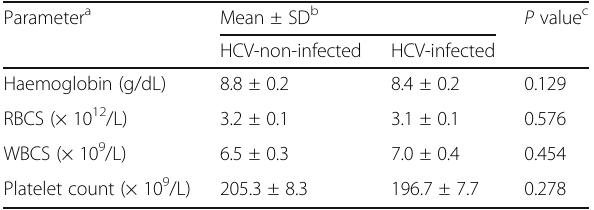
Table 4 Association of iron metabolism markers and other biochemical parameters with HCV